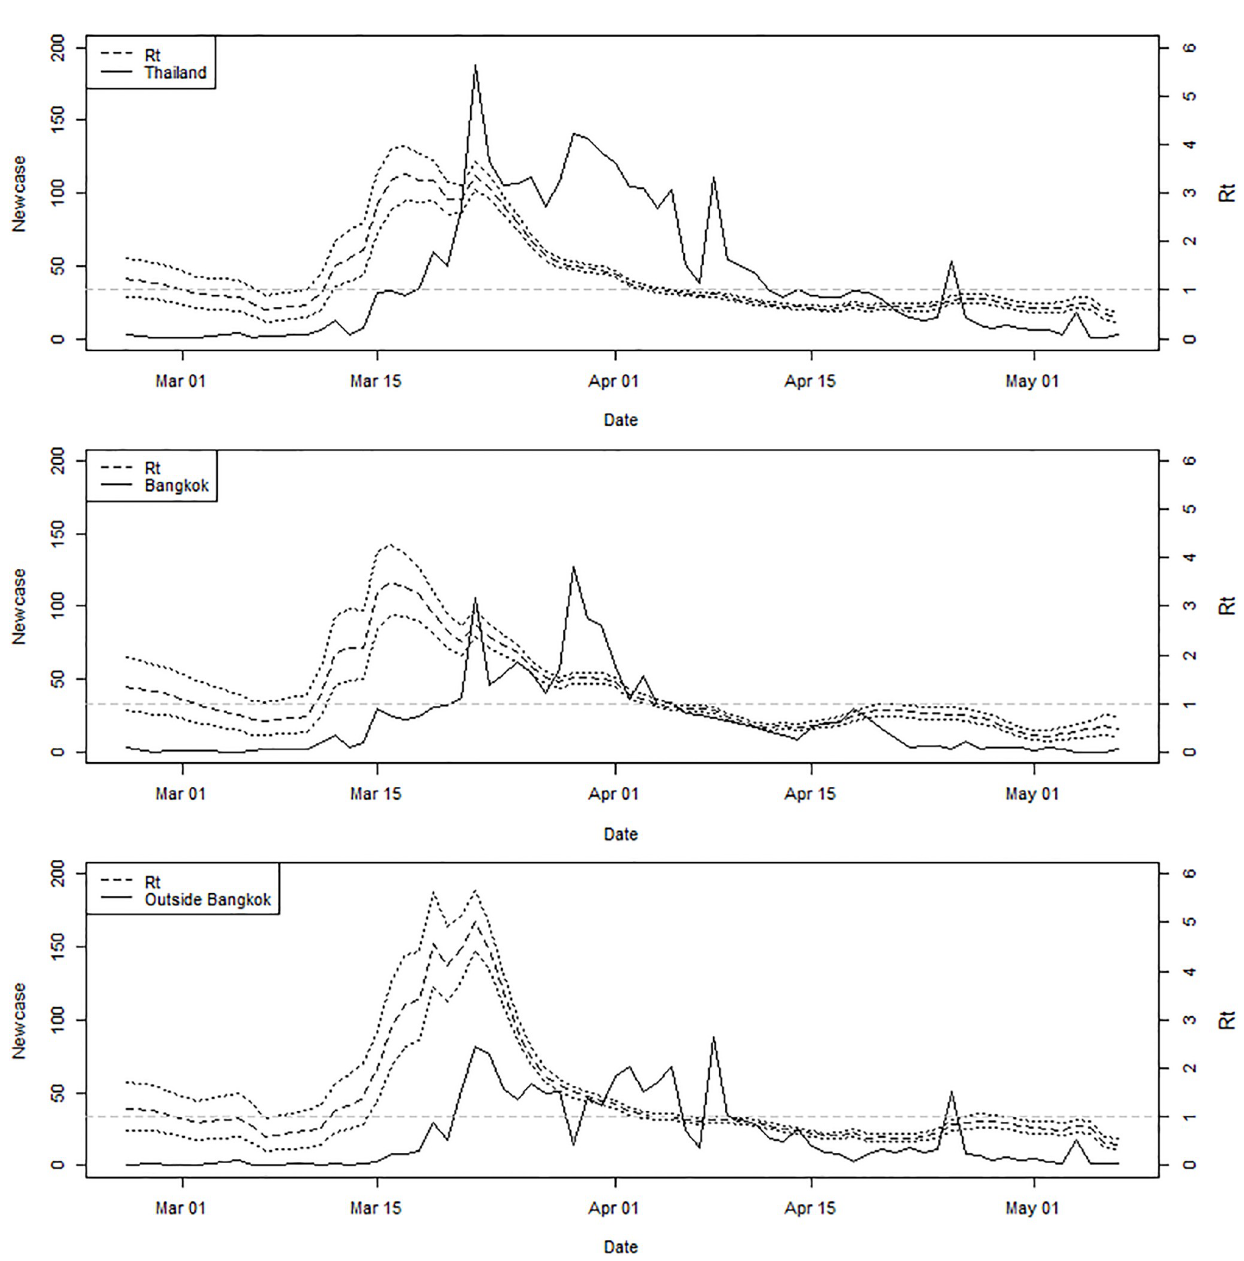
Fig 4. Plots of new cases (solid) and estimated R (dash) with 95% CI (dots) in Thailand within and outside Bangkok during February—March 2020. t The critical value of R t = 1 is marked with a grey dashed horizontal